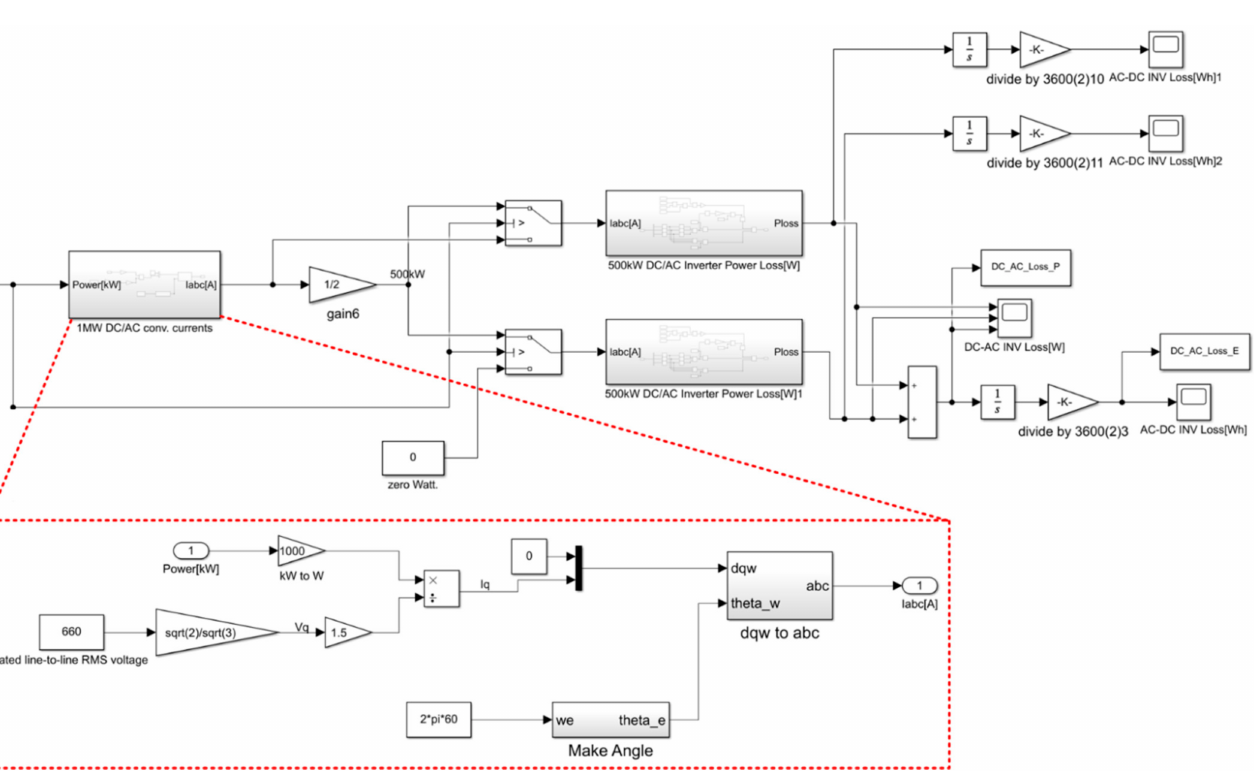
Figure 20. MATLAB/ SIMULINK model of 500 kW DC/AC inverter power